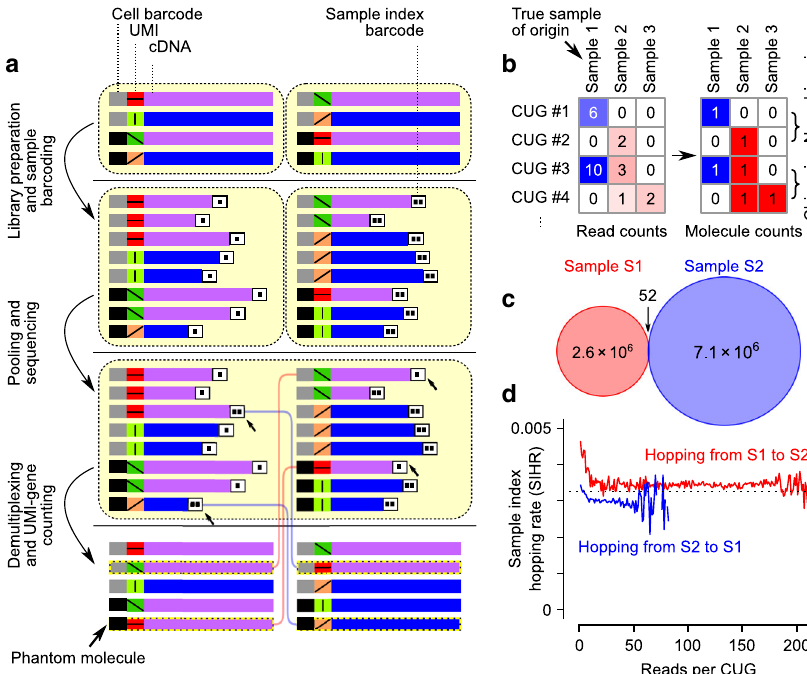
Fig. 1 A model for sample index hopping. a A schematic representation of sample index hopping. b A toy example showing a read count matrix (left) and the resulting molecule count matrix (right). In this example, the true sample of origin of all reads is sample 1. Blue depicts the reads/molecules that are correctly assigned to their true sample of origin, whereas red represents the hopped reads and the resulting phantom molecules, with the color intensity showing relative counts. A CUG is a unique cell – UMI – gene combination — CUGs that have a nonzero count in only one sample are called non-chimeric, whereas CUGs with nonzero counts in more than one sample are chimeric. See also Supplementary Tables 9 – 10. c Venn diagram showing the number of CUG collisions between two libraries that were sequenced on two separate HiSeq 4000 lanes (see “ Methods ” ). Note the minuscule fraction of CUGs that collide (<6 in a million). d The proportion of hopped sample indices by source sample across a range of PCR ampli fi cation levels r , in a multiplexed dataset with known ground truth (the sample of origin of each CUG was determined based on non-multiplexed sequencing runs of the same libraries on two separate lanes, i.e., c ). The straight dashed line shows the marginal mean of proportion of hopped reads. Note that the different lengths of the red and blue lines re fl ect the range of r for which there were enough observations in each sample to calculate the index-hopping